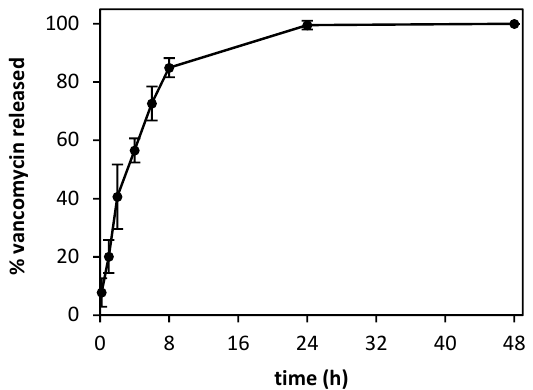
Figure 5. Drug release of vancomycin HCl from the chitosan aerogels (37 °C, 400 rpm, PBS pH 7.4) was sustained over time, reaching 100% of release after 24 h.